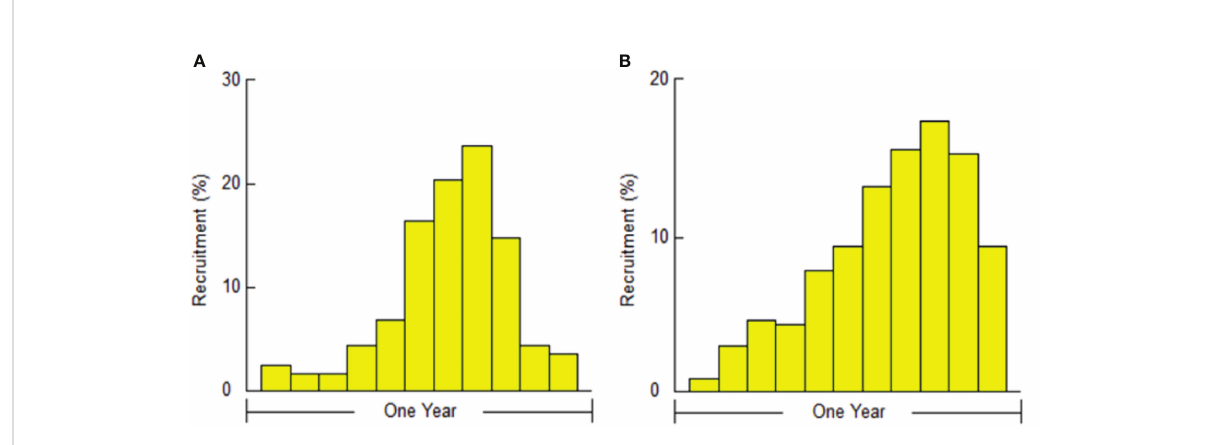
FIGURE 12 The perceptual recruitment pattern of (A) male and (B) female P. adspersus from the southeast Caspian Sea (2019 – 2020).